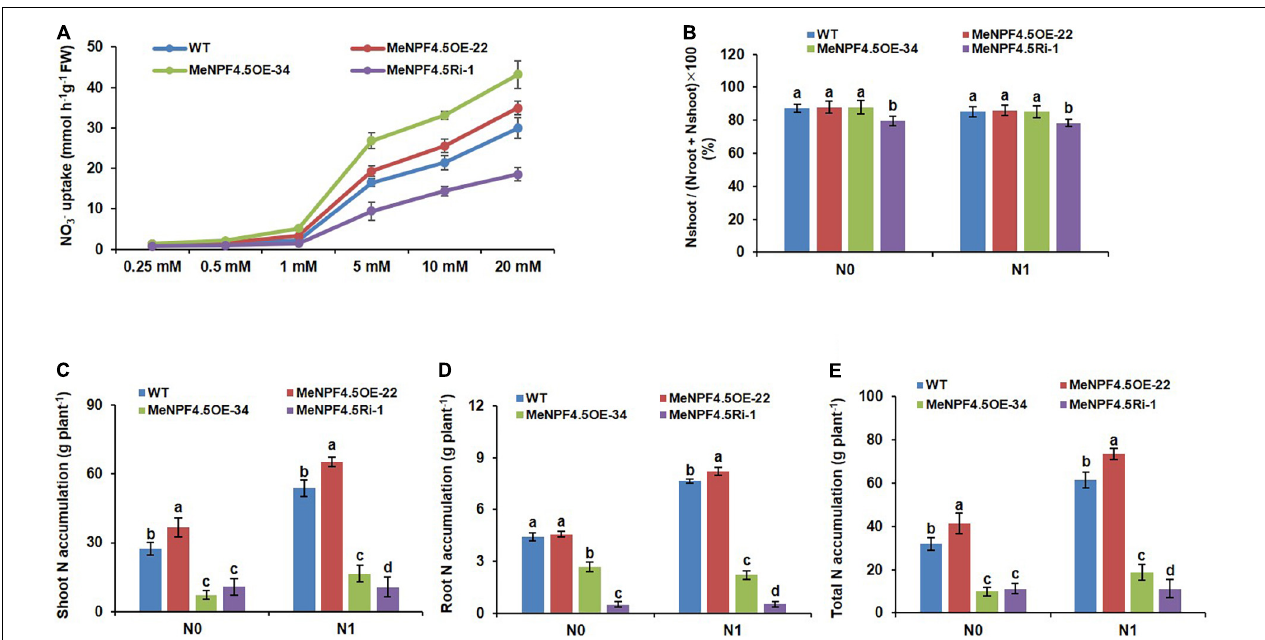
FIGURE 4 | Nitrogen uptake, tanslocation and accumulation in WT and MeNPF4.5 transgenic cassava plants. (A) Root NO 3 − uptake in WT and MeNPF4.5 transgenic cassava plants. WT and MeNPF4.5 transgenic cassava plants grown in 20 mM KNO 3 for 25 days and then deprived of N for 3 days. N-starved plant roots were then exposed to various NO 3 − concentrations for 6 h, uptake of NO 3 − were measured by disappearance of NO 3 − from the nutrient solution. (B) Nitrate translocation in WT and MeNPF4.5 transgenic cassava plants. (C–E) N accumulation in wild-type (WT) and MeNPF4.5 transgenic cassava plants harvested from the field. (C) Shoot N accumulation. (D) Root N accumulation. (E) Total N accumulation. Values are the means of three biological replicates ± SE. Lowercase letters above the bars (a–d) represent significant differences between treatments as determined by Student’s t -test ( P < 0.05). N0, low-N treatment, 0 kg ha − 1 ; N1, normal N treatment, 125 kg ha − 1